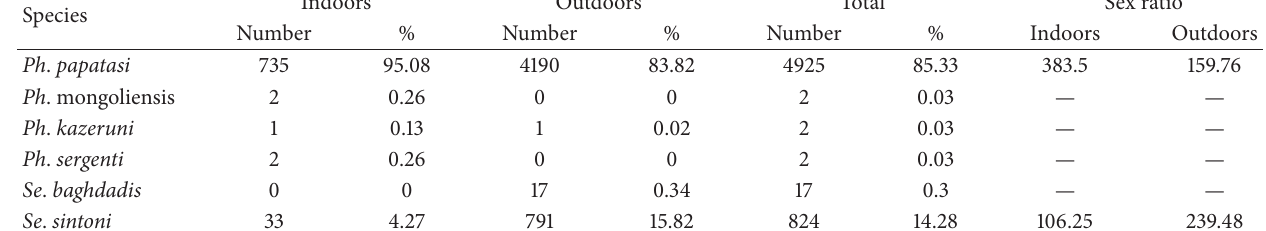
Table 3: Fauna, density, and sex ratio of sand flies in Khatam County, Yazd Province, 2006. Indoors Outdoors Total Sex ratio Species